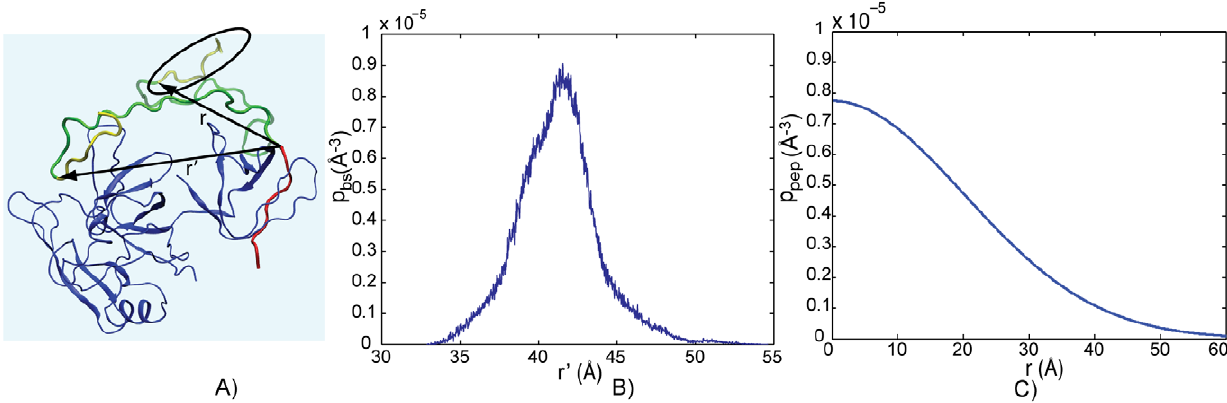
Figure 5. Example calculation for C eff . In (A) the two motifs that bind to Grb2 (blue) are shown in red and yellow while the linker in Sos1 connecting them is shown in green. After one of the motifs binds to Grb2, the local concentration ( C eff ) of the other Sos1 motifs that the free SH3 domain of Grb2 feels increases (circled) as Sos1 is tethered to Grb2. In order to calculate C eff , we used MD simulations (B) to determine the distance between the C a atoms at the two ends of the motif when they are bound to Grb2 ( p bs ( P 1 N , P 2 C , r 0 ) ) and the WLC model (C) to determine the probability densities of the distance between the C a atoms at the two ends of a linker ( p pep ( P 1, P 2, r ) ).